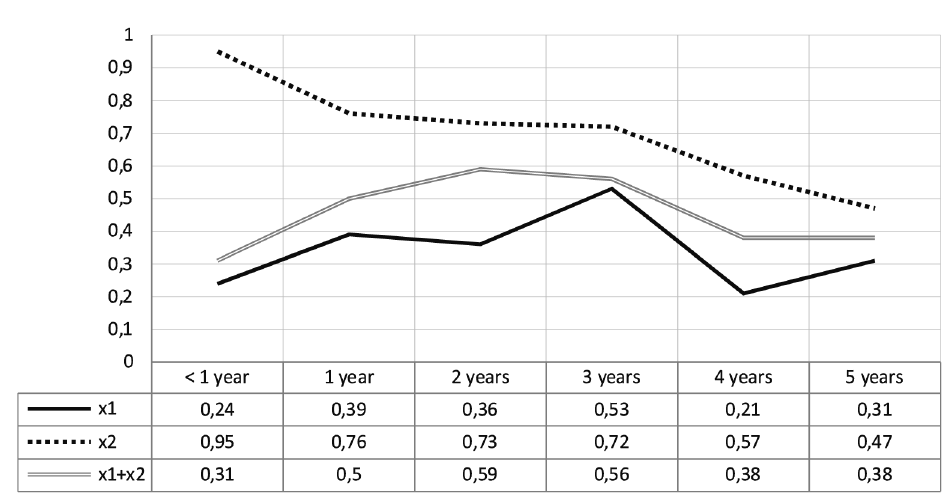
Figure 5. Summary of the SOSE retention index in 2018 for the brands x CUS and x including the years of vehicle use 2